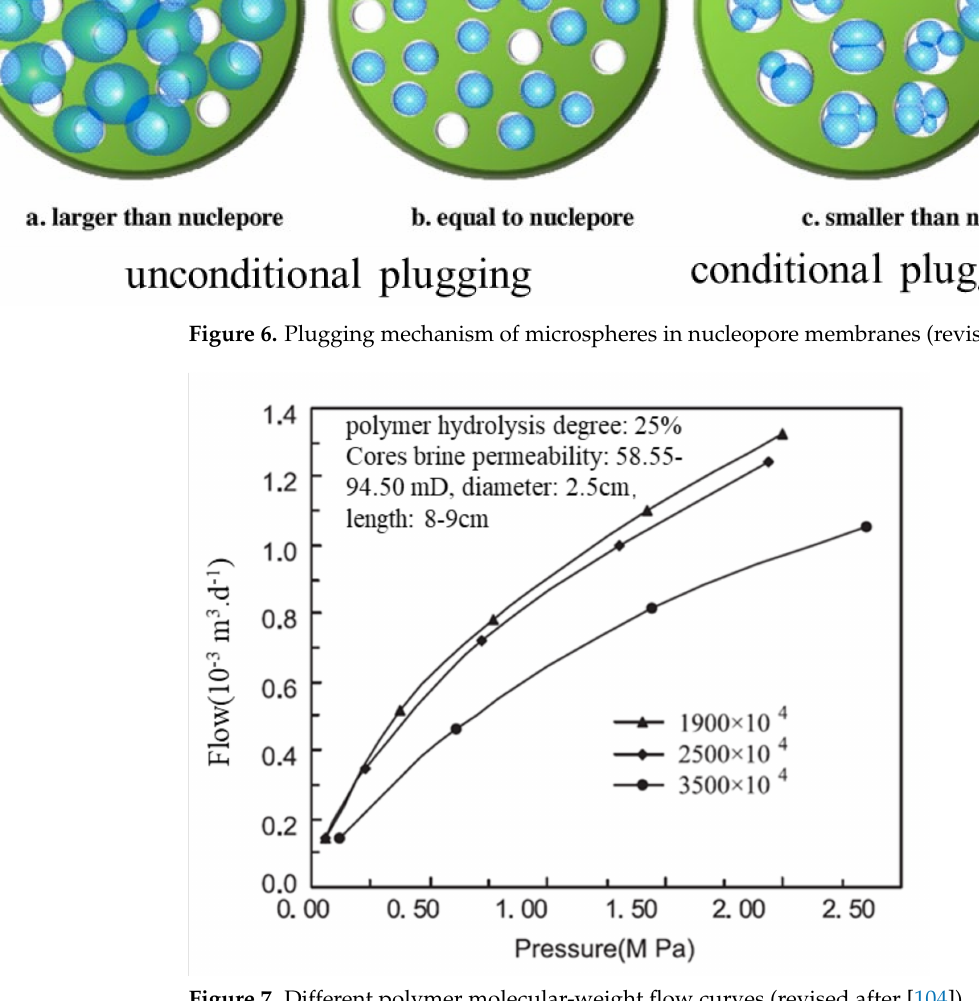
Figure 7. Different polymer molecular-weight flow curves (revised after